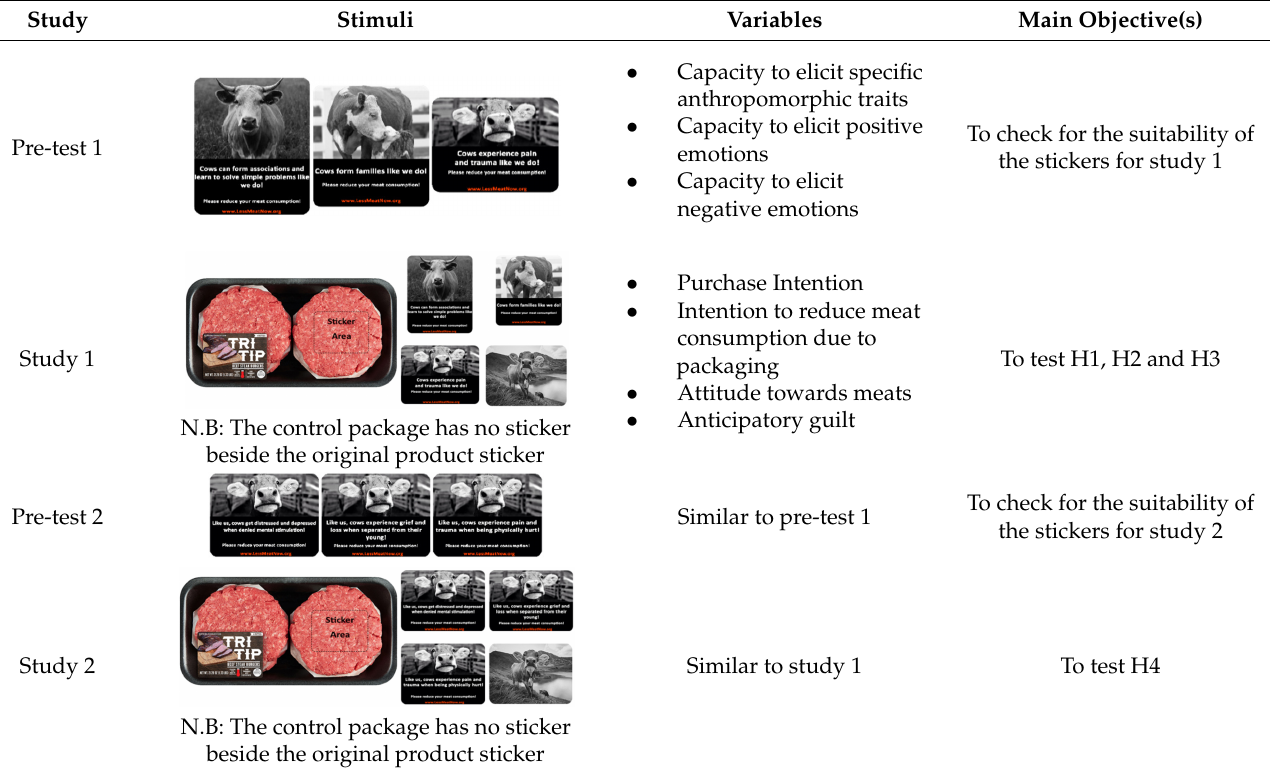
Table 1. All studies with their respective stimuli, variables and objectives.